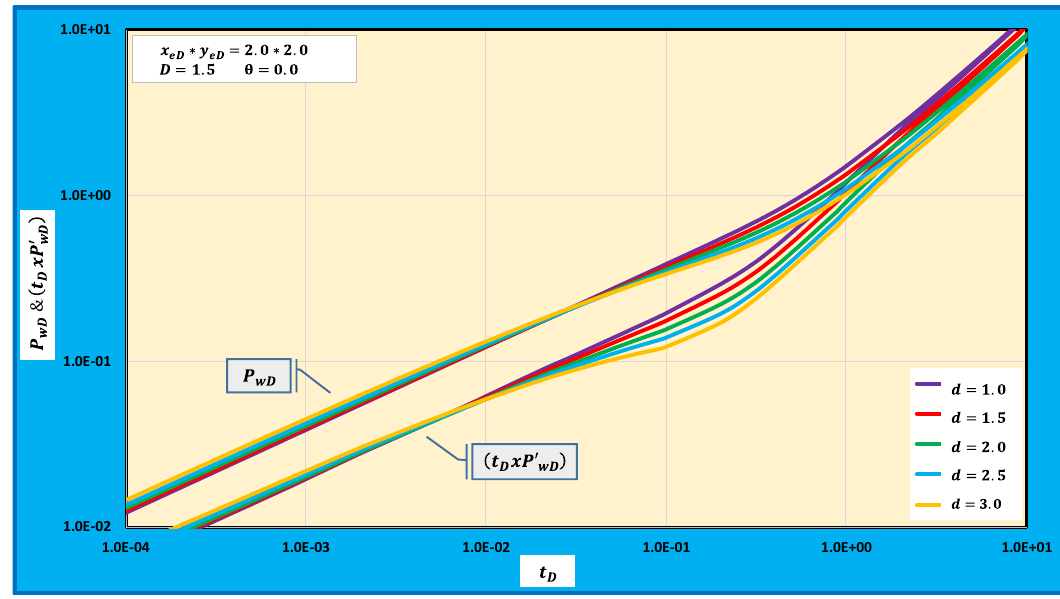
Fig. 5 Wellbore pressure and pressure derivative of different mass fractal dimensions